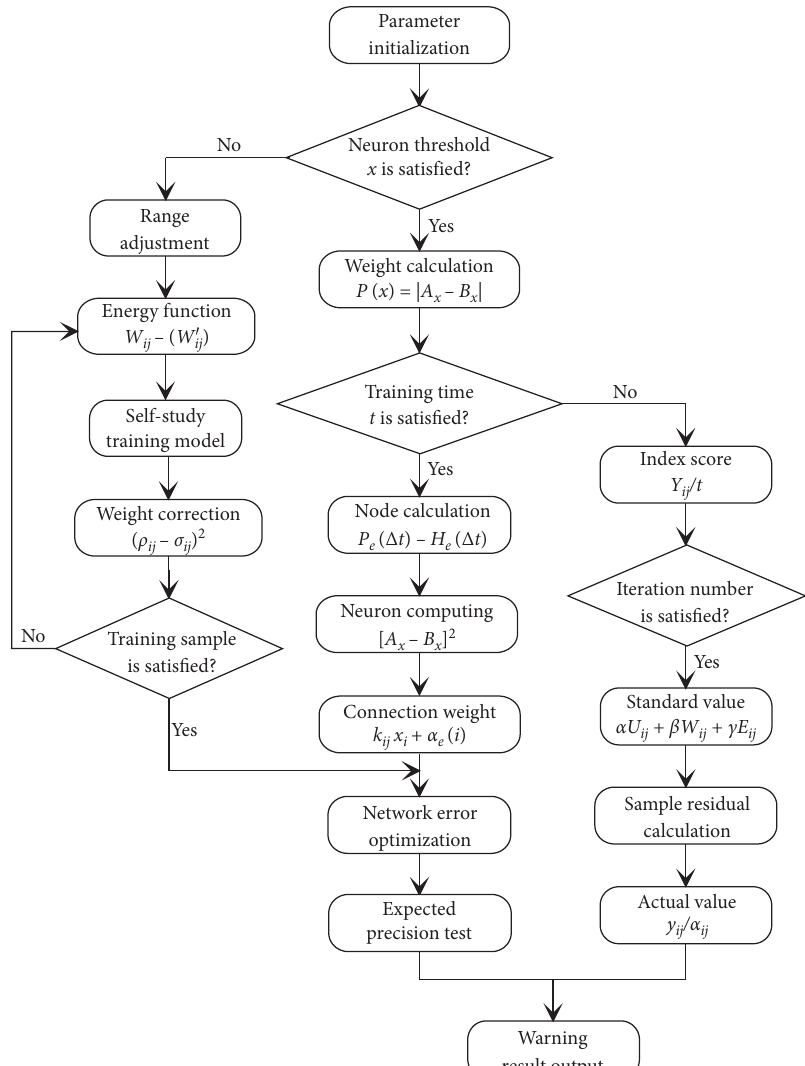
Figure 5: Analysis and simulation workflow of the early warning model for human resource management risk based on the BP neural